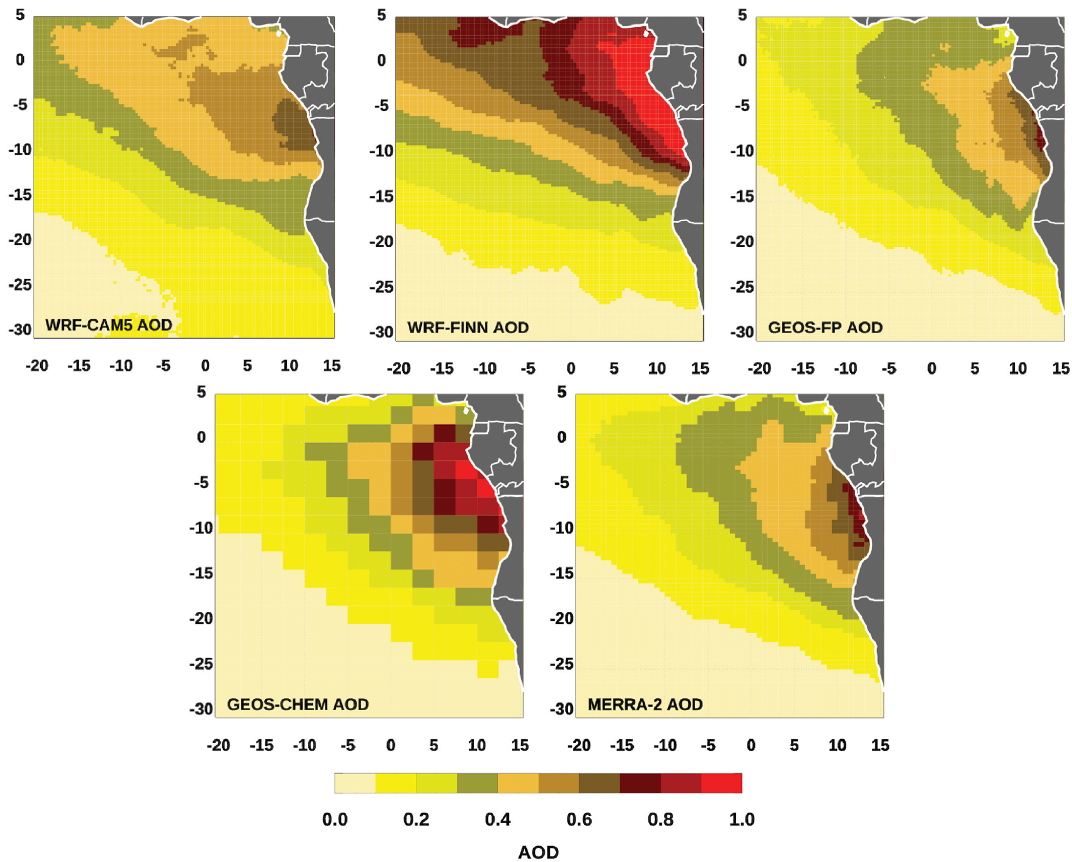
Figure 7. Monthly mean modeled total-column AOD at 12:00UTC for August